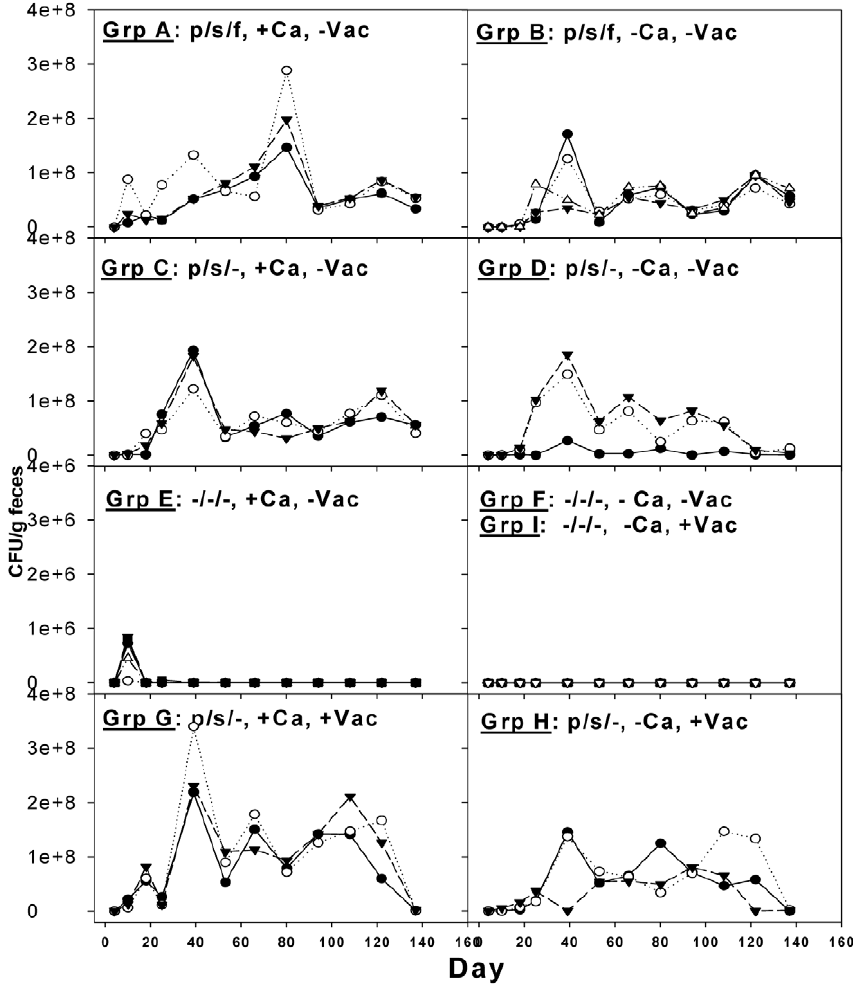
Figure 2. Antibacterial therapy is required for a protracted GI-tract colonization with C.albicans . Mice received oral administration of various combinations of antimicrobial agents, live C. albicans, and a peptide (Fba) vaccine. Control groups did not receive one or more of the treatments. All groups that received at least two of the antibacterial agents and were fed C. albicans for a five day period (e.g., groups A, C and G) developed a protracted GI-tract colonization with the fungus as evidenced by the presence of the fungus in fecal specimens. Antibiotics were required for the fungal colonization as shown by the presence of C. albicans in the feces of group E only during the five day feeding period. Surprisingly, antibiotic-treated mice that were not fed C. albicans also became colonized (groups B, D and H). These results suggested the possibility that antibiotic-treated mice are susceptible to horizontal transmission of the fungus. p=penicillin; s=streptomycin; f=fluconazole; + Ca= C. albicans in drinking water on days 5–9; + Vac=vaccinated with Fba. Each mouse in each group is represented by an open circle, closed circle or closed triangle.